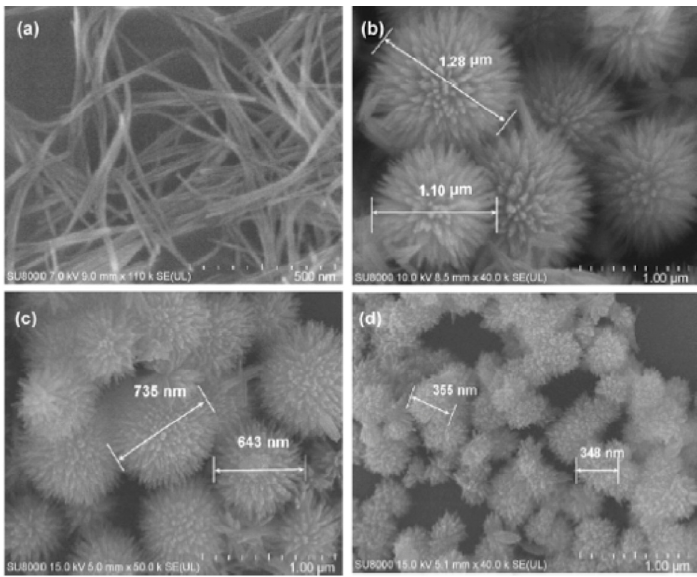
Figure 6. The SEM images of LaPO 4 with change in citric acid amount (a) 0 mg, (b) 10 mg, (c) 100 mg and (d) 500 mg, reprinted with permission from [86].